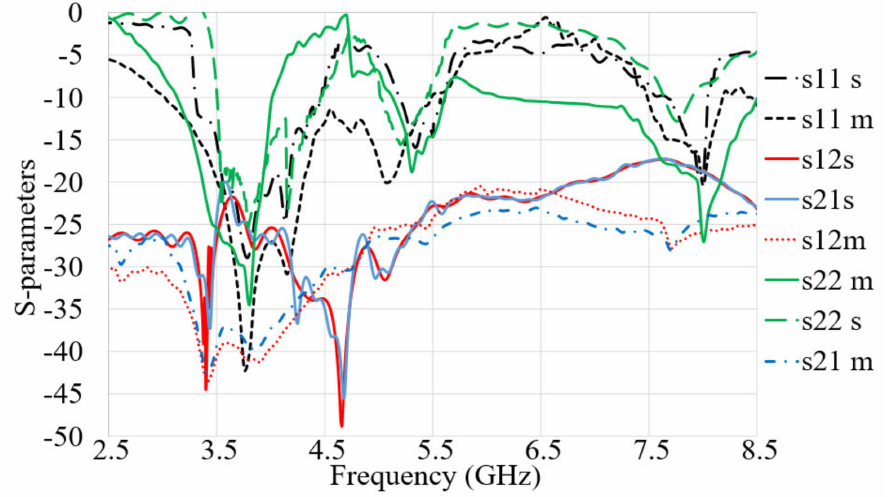
Figure 13. The simulated and measured S 11 , S 12 , S 21 , and S 22 results of the proposed antenna (s: Simulation, m: